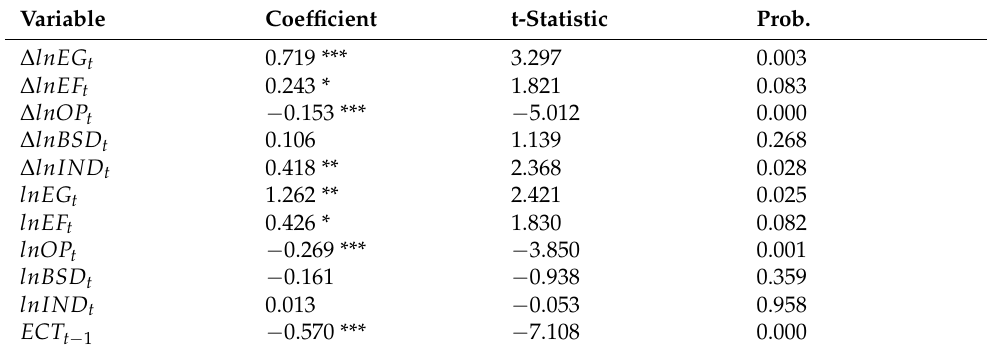
Table 4. ARDL model